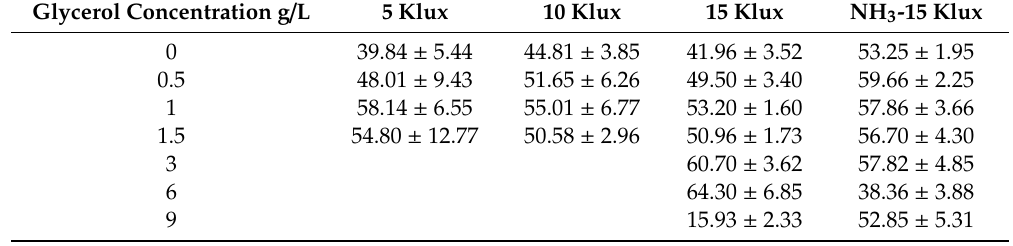
Table2. Proteincontentof A.platensis cultivatedunderdifferentglycerolconcentrationsandlightintensities.